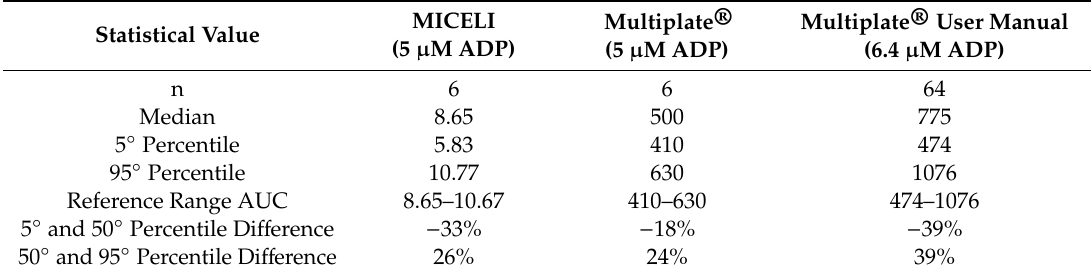
Table A1. The range of interdonor distribution of AUC values for aggregation, recorded by the MICELI and the Multiplate ®